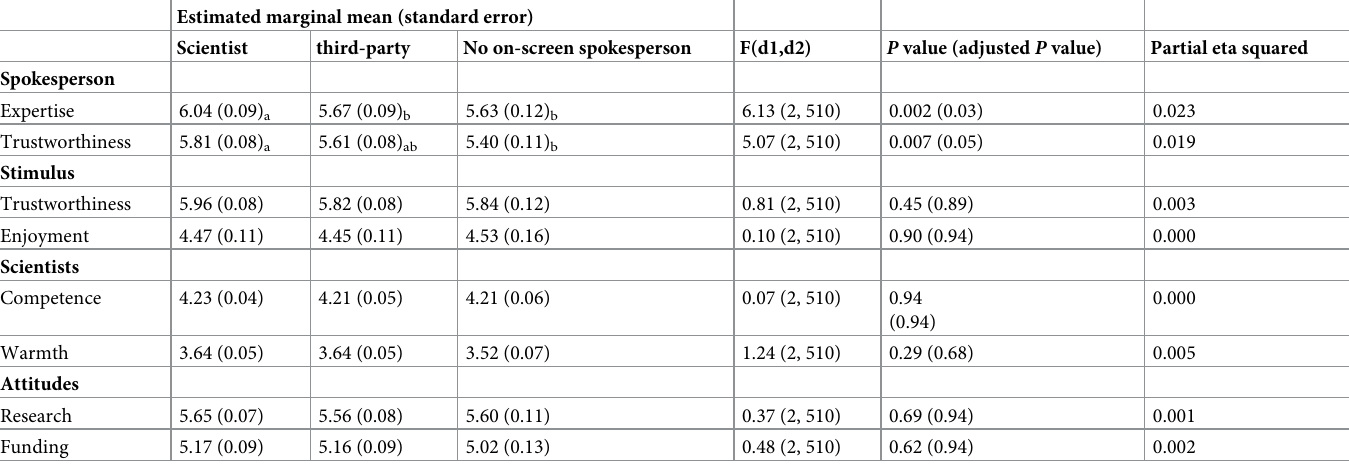
Table 3. ANCOVA and post-hoc analyses of the effects of treatment (scientist vs third-party vs no on-screen spokesperson) on outcome measures. Estimated marginal mean (standard